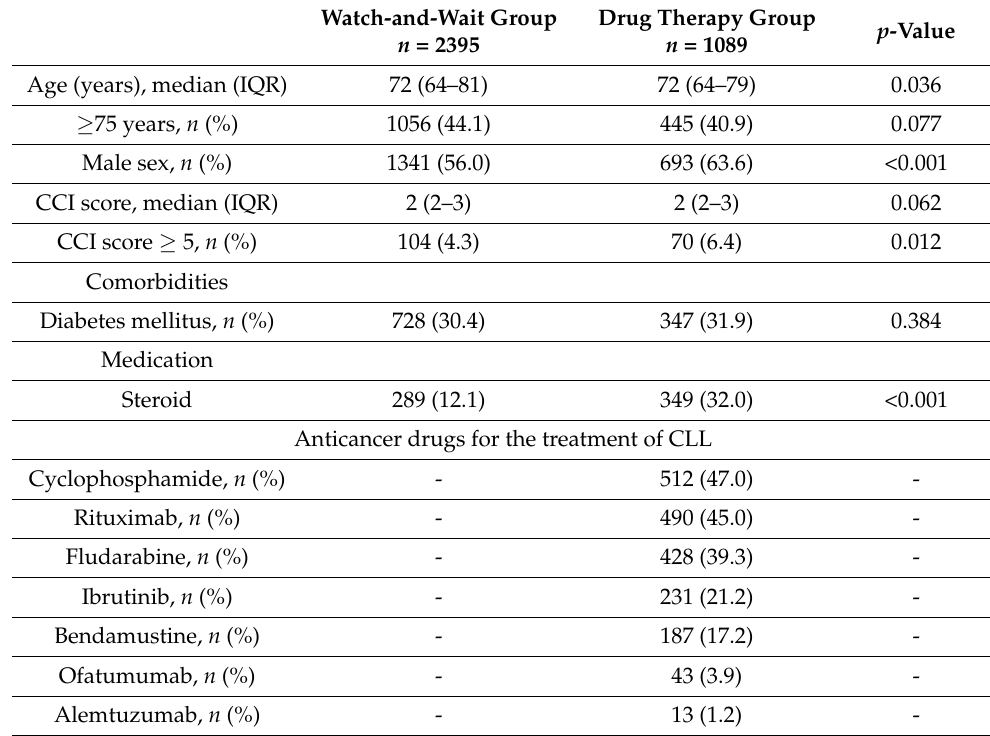
Table 1. Baseline patient characteristics.